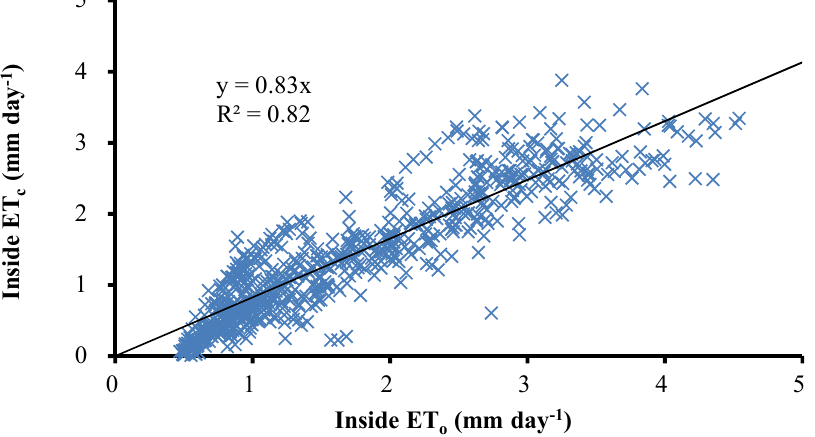
Figure 14. The relationship between estimated crop evapotranspiration (ET c ) and reference crop evapotranspiration inside the sunken solar greenhouse (ET o,in ) during the experimental period.